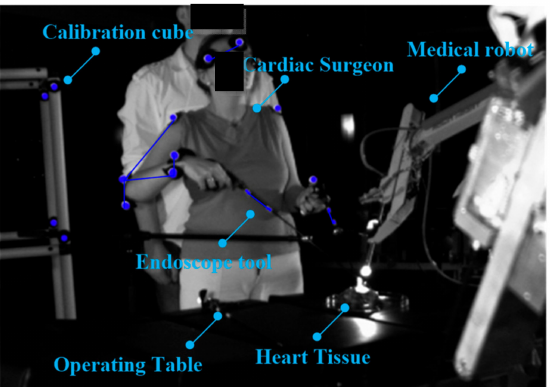
Figure 4. Surgeon with two endoscopic instruments and the surgical robot “Robin Heart Vision” with an endoscopic camera. The surgeon is operating upon heart tissue ( Sus scrofa f. domestica ) and observes the operations on the monitor above the